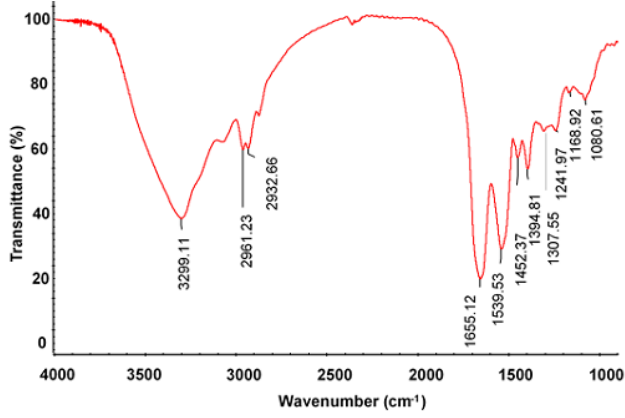
Figure 5. FT-IR spectra of PSAF.